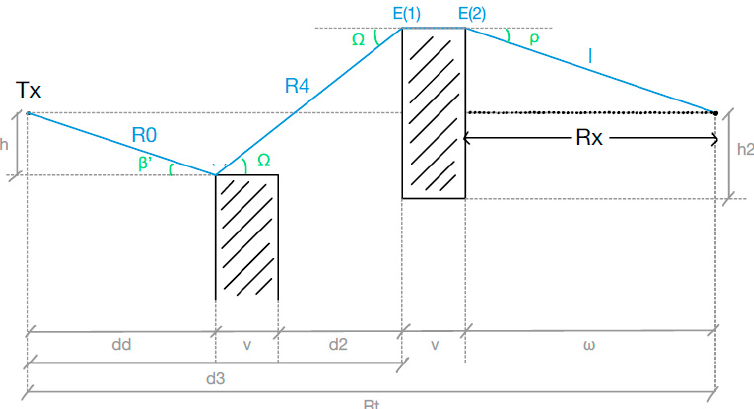
Figure 19. First triple diffraction (Edif_t1) of the second considered NLOS scenario.